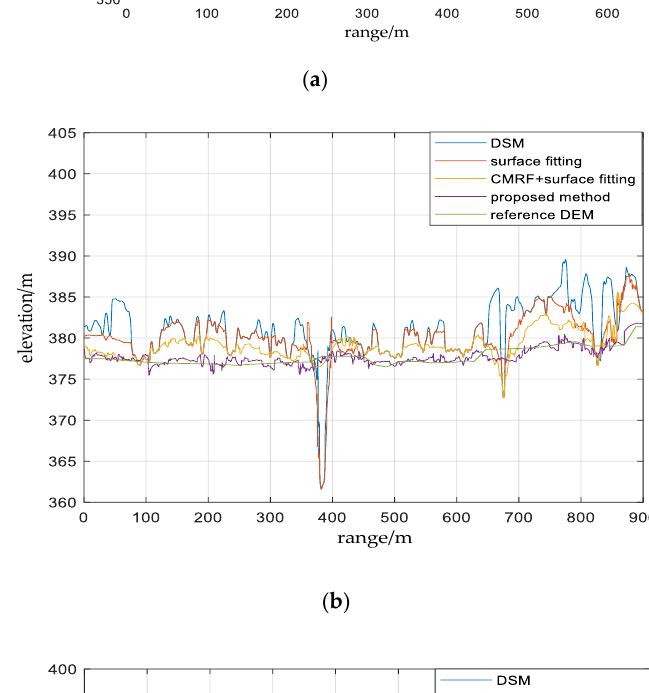
Figure 10. Visual comparison of before and after processing of the InSAR DSM, where ( a – c ) are the original DSMs, ( d – f ) are the reference DEMs obtained by laser detection and ranging (LiDAR), ( g – i ) are the reconstructed DEMs based on surface fitting, ( j – l ) are the reconstructed DEMs based on coherent Markov random field (CMRF)+surface fitting, and ( m – o ) are the reconstructed DEMs based on proposed method.